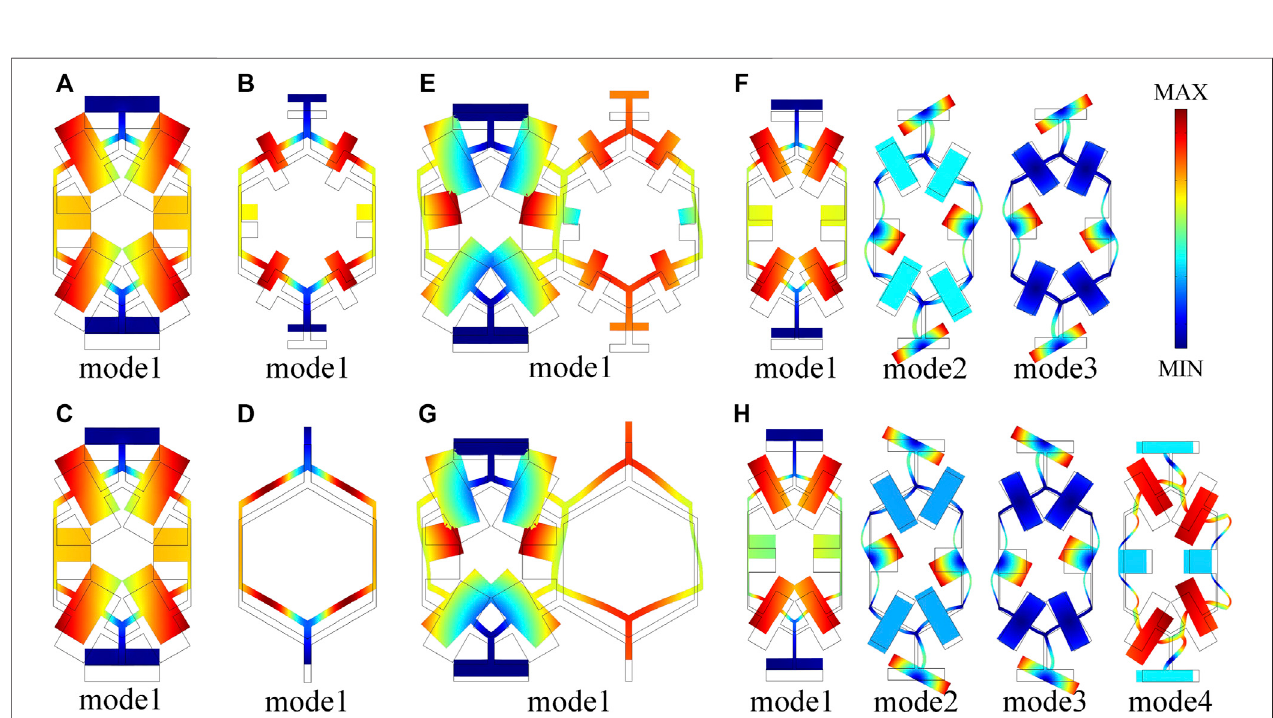
FIGURE 4 | The vibration mode of the above-mentioned cellular structures in the range of 20 – 40 kHz. (A) Cellular structure A. (B) Cellular structure B. (C) Cellular structure C. (D) Cellular structure D. (E) Microstructure A + B. (F) Cellular structure E. (G) Microstructure C + D. (H) Cellular structure F.